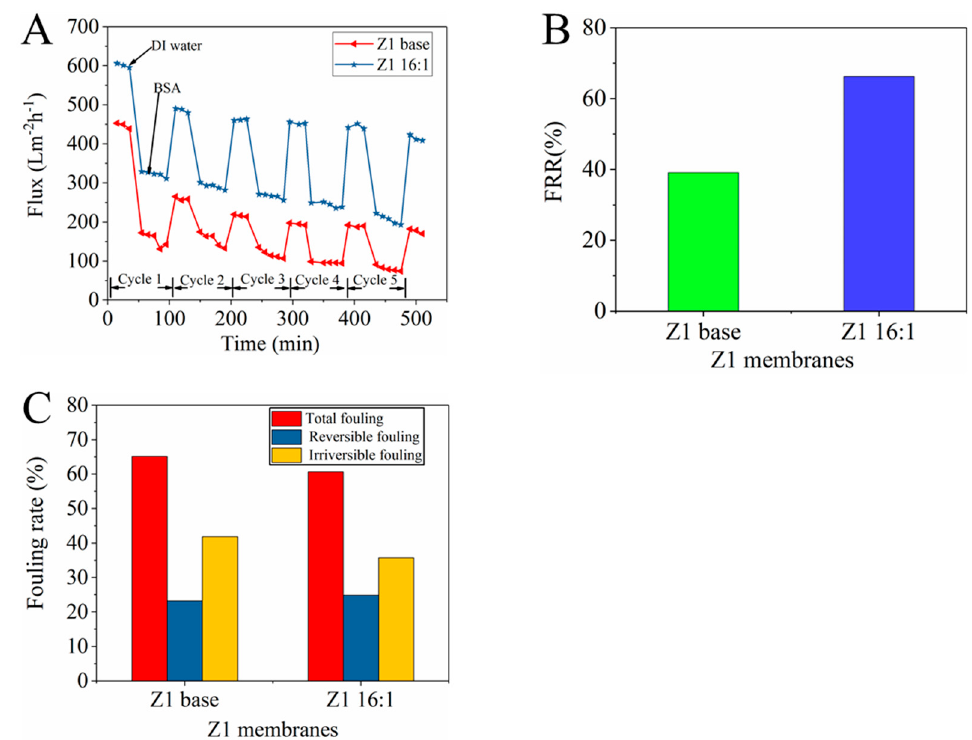
Figure 10. Antifouling properties of the prepared membranes ( A ) time dependent flux, ( B ) flux recovery ratio, and ( C ) fouling